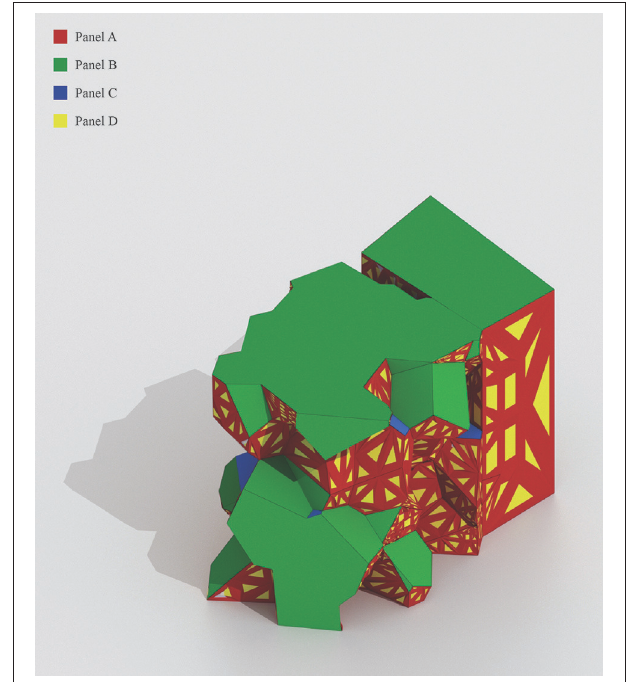
FIGURE 2 | The final material subdivision of the façade.